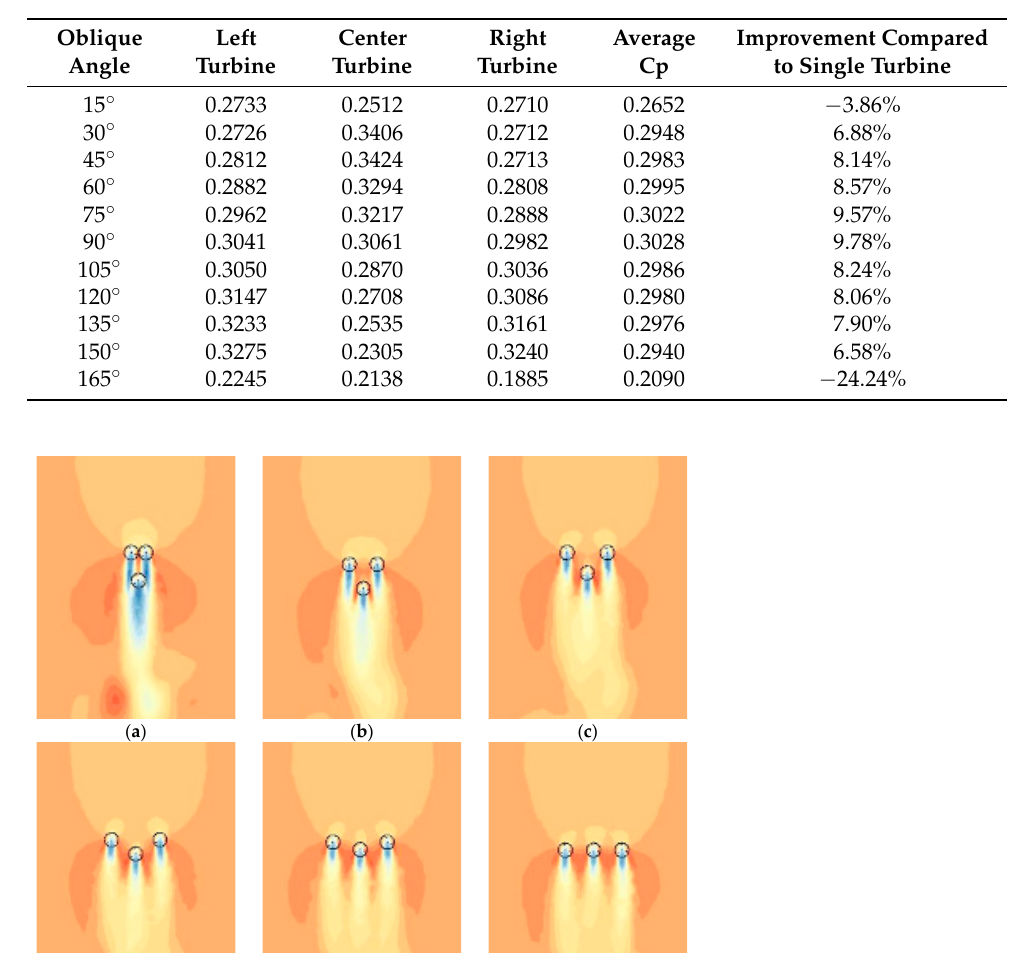
Table 6. Coefficient of performance at different oblique angles.